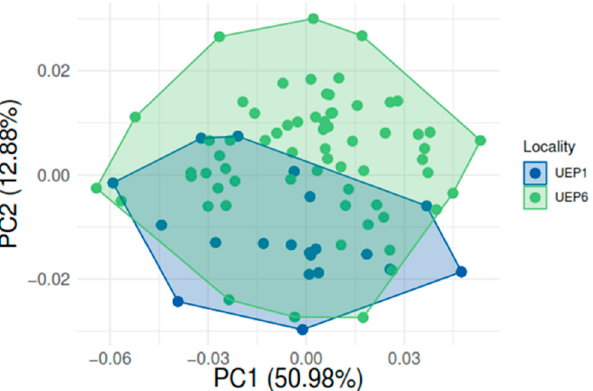
Figure 3. Principal Component Analysis of Plagioscion magdalenae between location. The colors represent the different sample locations: blue, UEP1—Ciénaga de Capote, and green, UEP6— Ciénaga de Jobo.